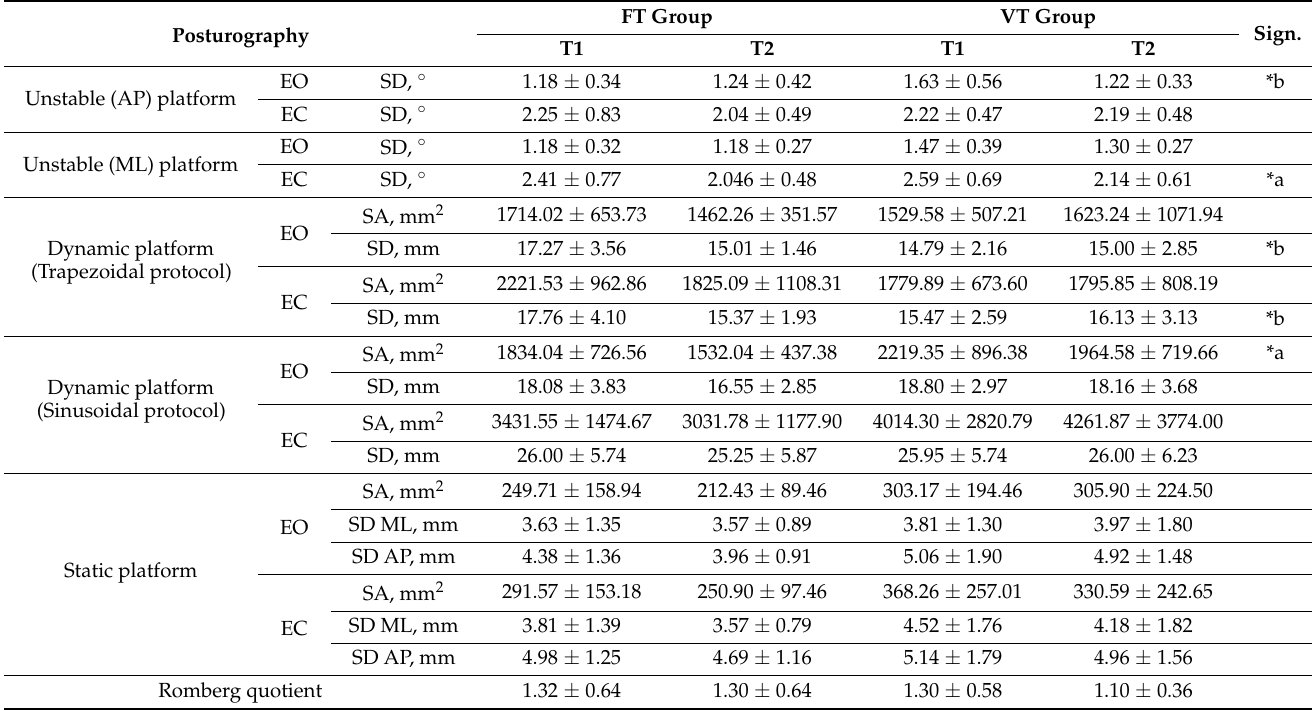
Table 3. Values of the postural evaluation parameters with static and dynamic posturography: unstable platform, sinusoidal or trapezoidal platform oscillations, for Face-to-Face Training Group and Videoconference Training Group before (T1) and after (T2) the training period. SA—the sway area, SD—Standard Deviation of the postural sway along the Anterior- Posterior axis (AP) and Medial-Lateral axis (ML) or of the angle of the platform tilt. EO—eyes open, EC—eyes closed. Sign.—Significance level * p ≤ 0.05; a: intervention effect (corresponds to a significant effect of intervention for both groups), b: interaction effect (corresponds to a significant effect of intervention that is different between